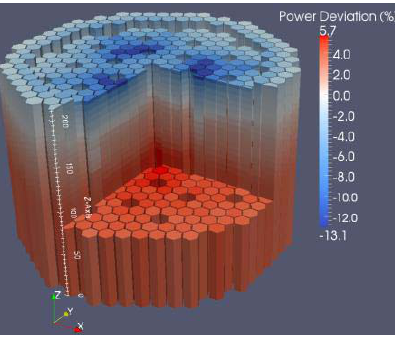
Figure 6 - ULOF Scenario: Reactivity feedback effects before boiling onset – Point Kinetic model